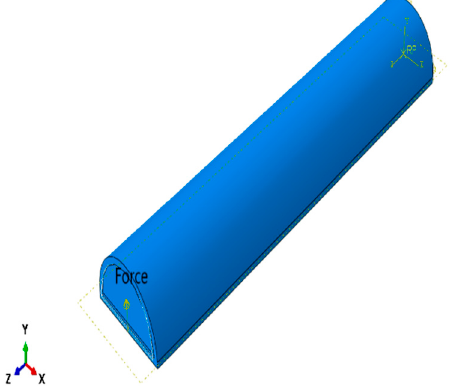
Figure 24. Simulation results of PI controller with Kp = 1.5, Ki = 0.5. After the first simulation, a concentrated force is added at the tip of the actuator to simulate the finger’s resistance to the actuator, as shown in Figure 25. The job is resubmit- ted, and results are extracted. Figure 26 shows the results of simulation. From the simula- tion results we notice that tr = 0.24594 s, ts (5%) = 0.3684 s and ts (2%) = 0.502 s. Figure 25. Concentrated force at the face of the Figure 25. Concentrated force at the face of the SPA.